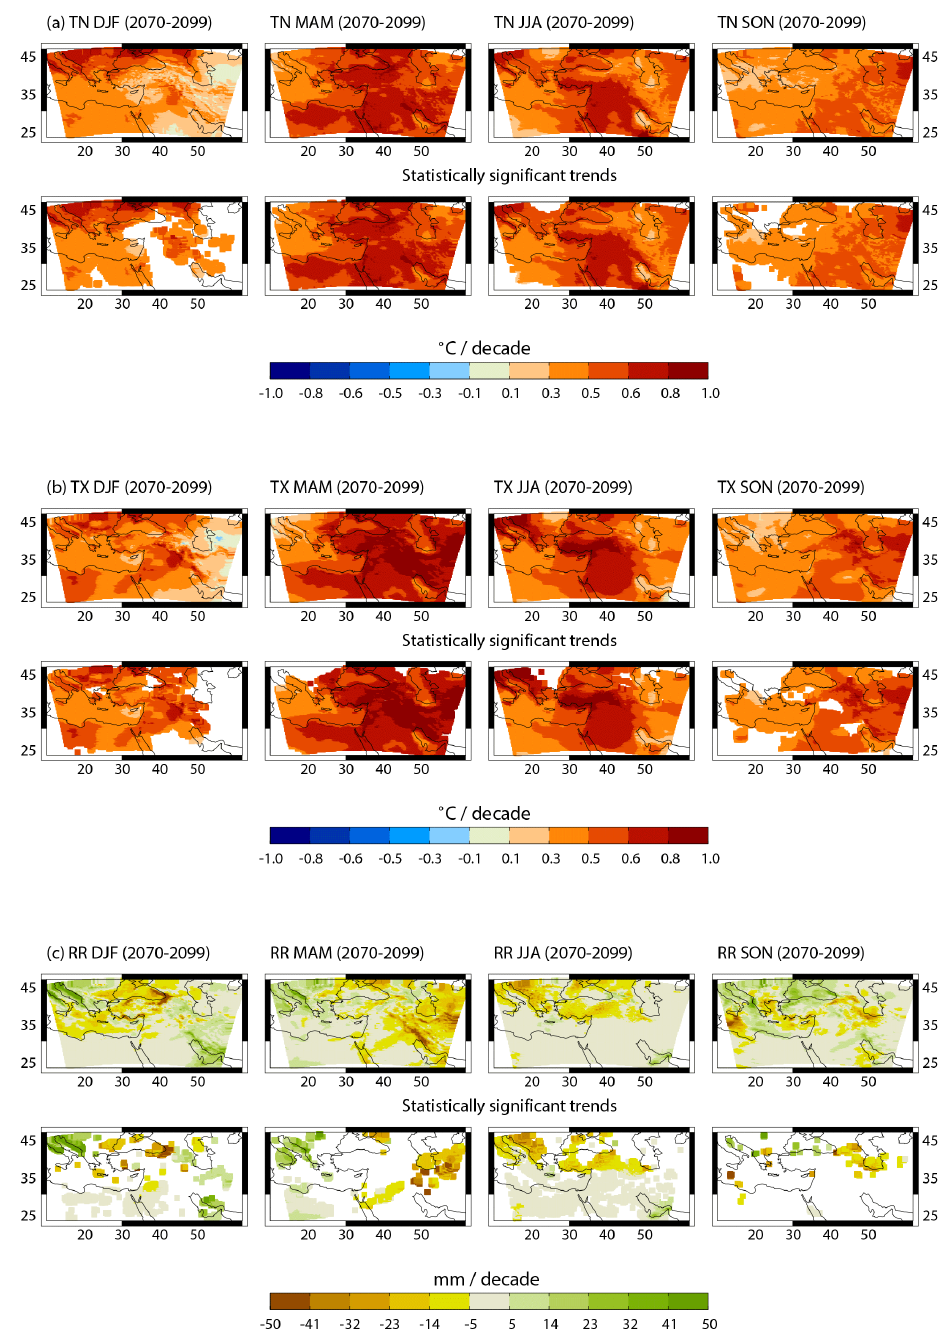
Figure 6. As in Fig. 4 for the future period